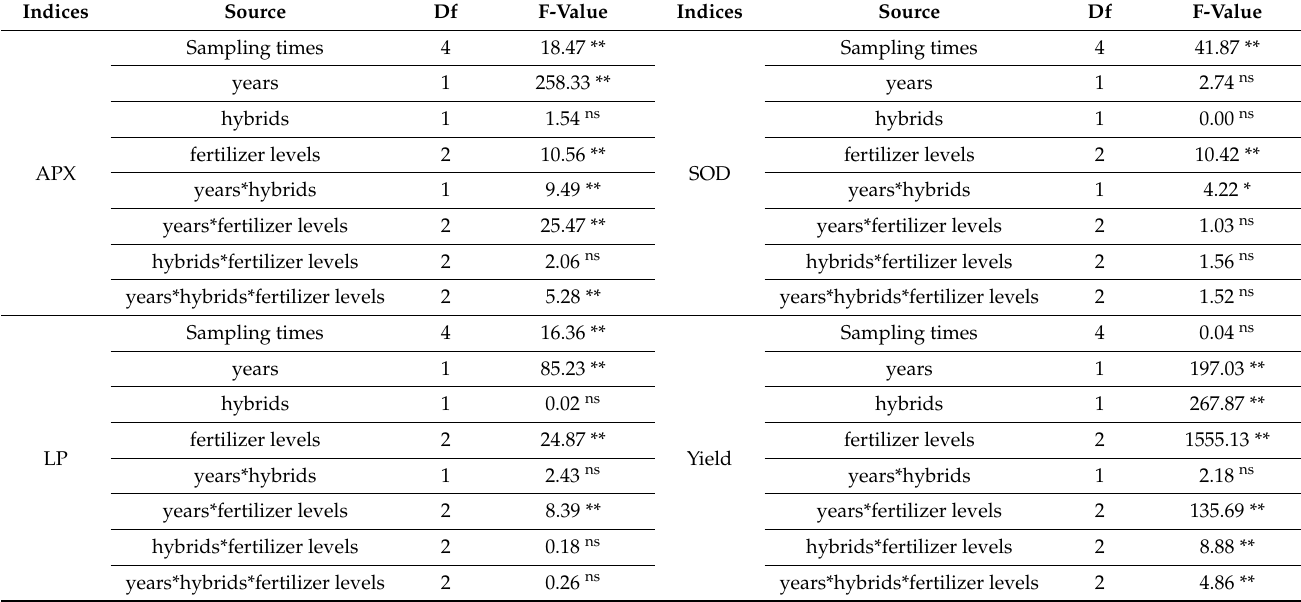
Table 4. Variance analysis based on nitrogen fertilizer.